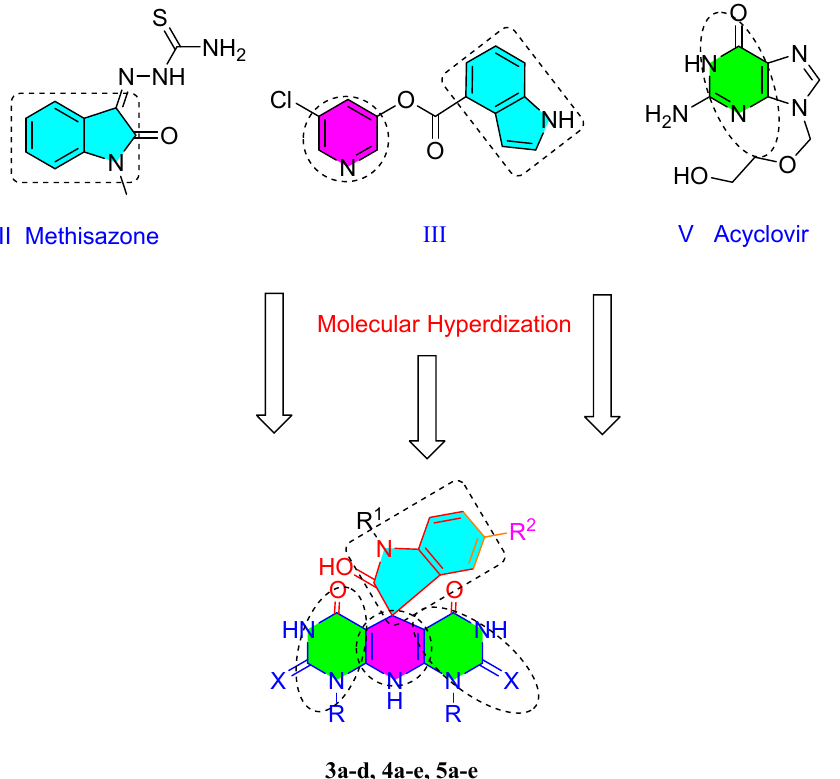
Figure 3. Design of new isatin–pyridine-pyrimidine conjugates as SARS–Cov–2 inhibitory agents.